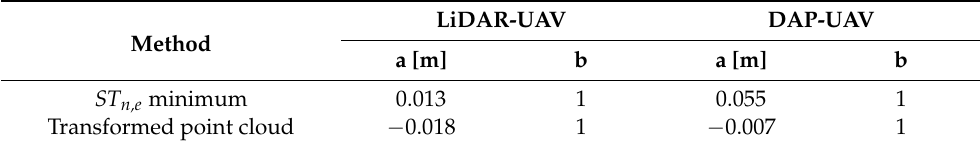
Table 3. Coefficients of the linear regression we performed between the ground elevation surveyed on the marsh system, and the one calculated in ST n,e by using: (i) the elevation of the lowest point of the non-transformed point clouds (first row); (ii) the elevation of the lowest point of the point clouds transformed by using a regression plane (second row). Results are reported for the LiDAR- and the Digital Aerial Photogrammetry (DAP)-UAV point clouds.